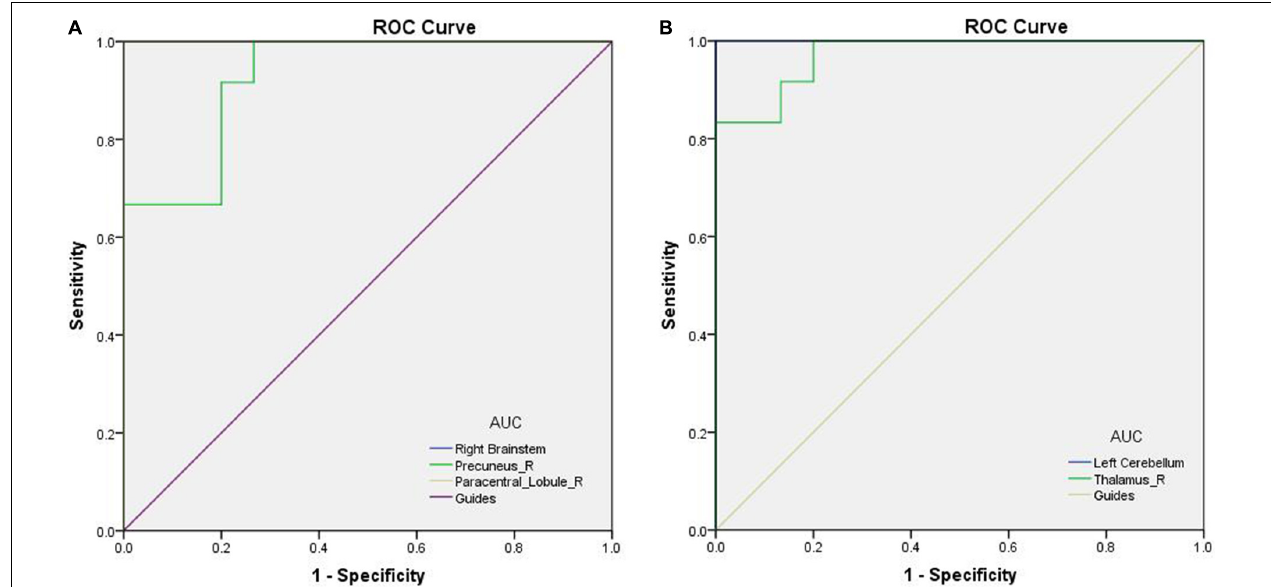
FIGURE 3 | ROC curves of the mean VBM values for abnormal brain areas in PATs. (A) AUC of the ROC curve: 1.000 for right brainstem (95% CI 1.000–1.000, p < 0.0001); 0.928 for right precuneus (95% CI 0.834–1.000, p < 0.0001); 1.000 for right paracentral lobule (95% CI 1.000–1.000, p < 0.0001). (B) The AUC of the ROC curve: 1.000 for left cerebellum (95% CI 1.000–1.000, p < 0.0001); 0.972 for right thalamus (95% CI 0.921–1.000, p < 0.0001). Abbreviations: VBM, voxel-based morphometry; AUC, area under the curve; ROC, receiver operating characteristic; and PATs, severely obese patients with meibomian gland disease.